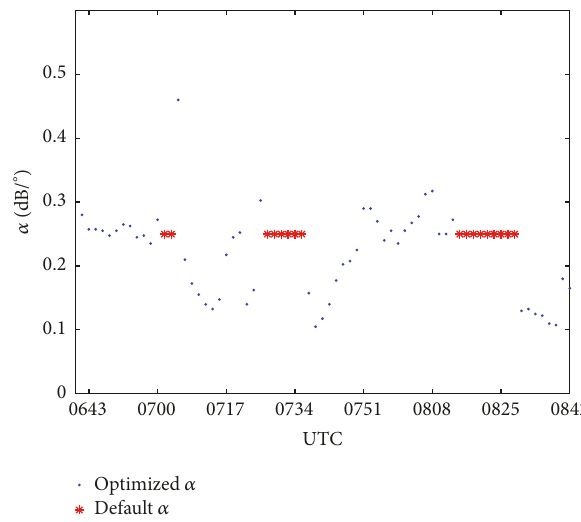
The result of the optimized 𝛼 during the rain event is shown in Figure